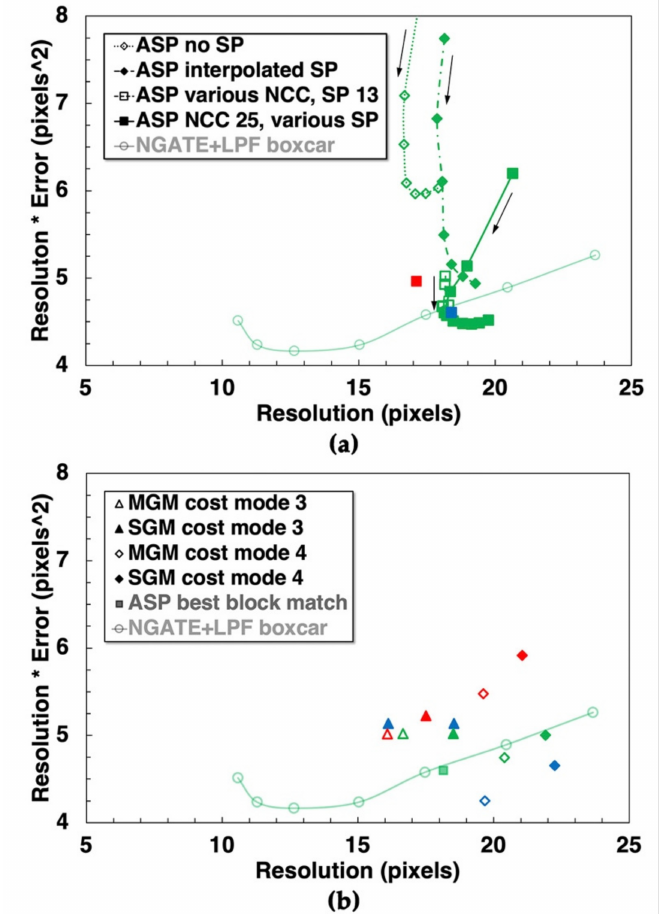
Figure 8. Quality factors for Jezero HRSC DTMs produced by using the Ames Stereo Pipeline. The product of resolution and matching error is plotted as in Figure 6b. Colors correspond to areas of different roughness outlined in Figure 2. ( a ) Results for block matching. Arrows indicate direction of increasing kernel size. For NCC with no subpixel refinement (open diamonds) or parabolic interpolation (diamonds), the product of resolution and error first decreases at constant resolution as NCC kernel size is increased, then remains almost constant as resolution increases slightly. With adaptive affine subpixel refinement, increasing SP kernel size at fixed NCC kernel size yields similar behavior (squares), but increasing NCC kernel size (open squares) has little effect. For clarity, results for rough (red) and smooth (blue) subareas are plotted only for the optimum set of kernel sizes. ( b ) Results for the ASP SGM and MGM matchers with two cost functions (see text). Results are shown for a kernel size of 9 pixels, which yielded the best DTM